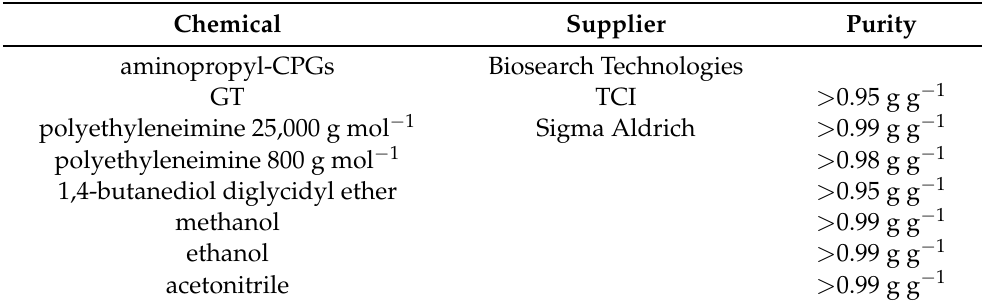
Table A1. Chemicals used in the presented immobilization procedure of GT onto aminopropyl- functionalized CPGs are listed with the respective suppliers and